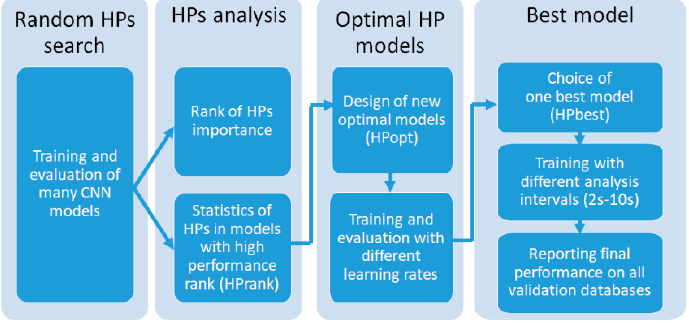
Figure 3. Process of hyperparameter (HP) search, analysis and optimization for justification of the best deep neural network (DNN) model.